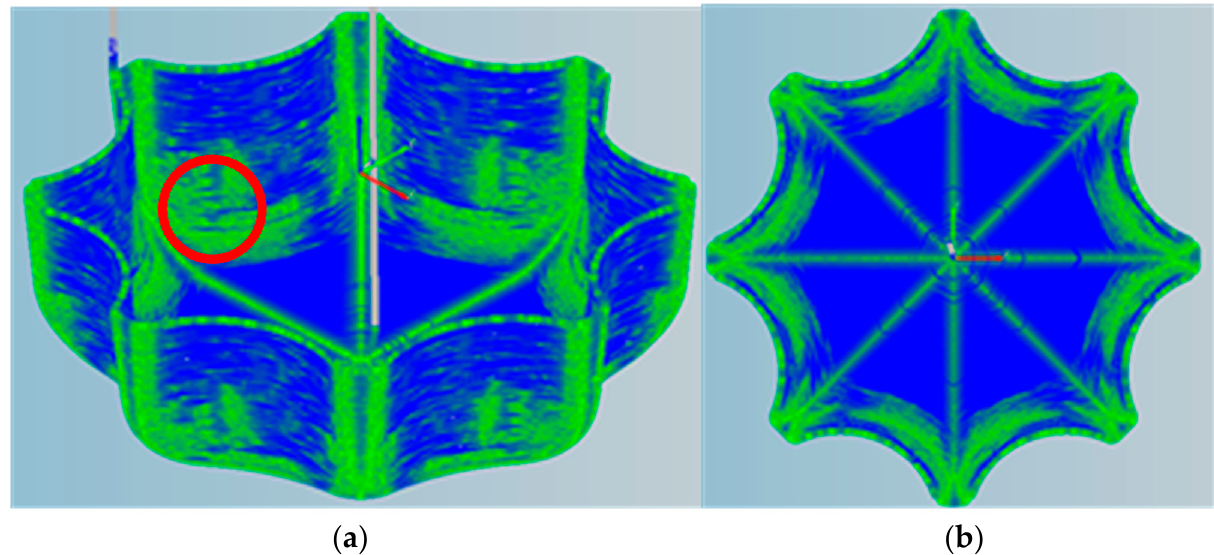
Figure 10. Visualization of Coke Bottom before optimization ( a ) before optimization ( b ) after optimization.